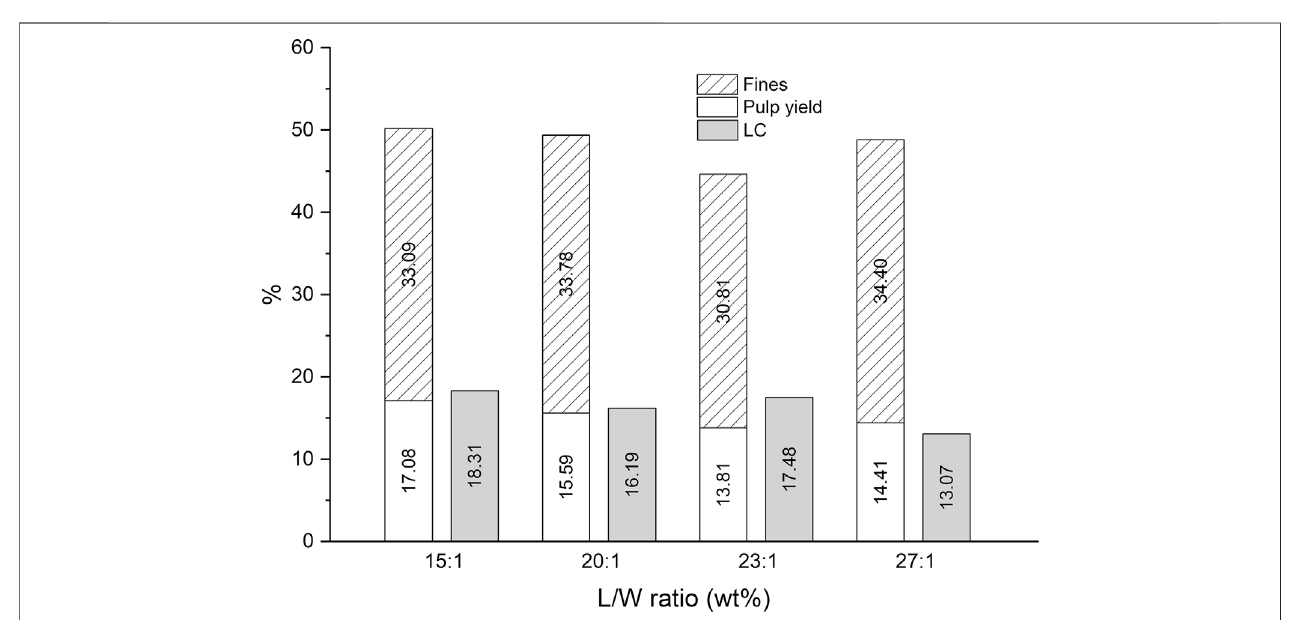
FIGURE 2 | The effect of the L/W on the pulp yield, fi nes, and the lignin content in the DES-cooking of Asplund fi bers (1 h of cooking at 130 ° C by using the RE setup).